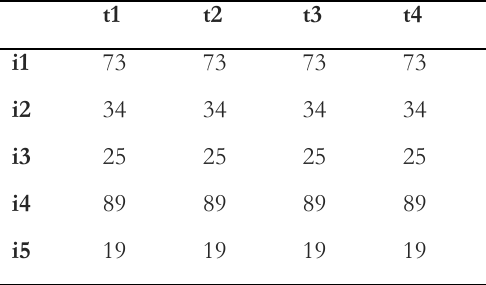
Table 10. Various facility demands.